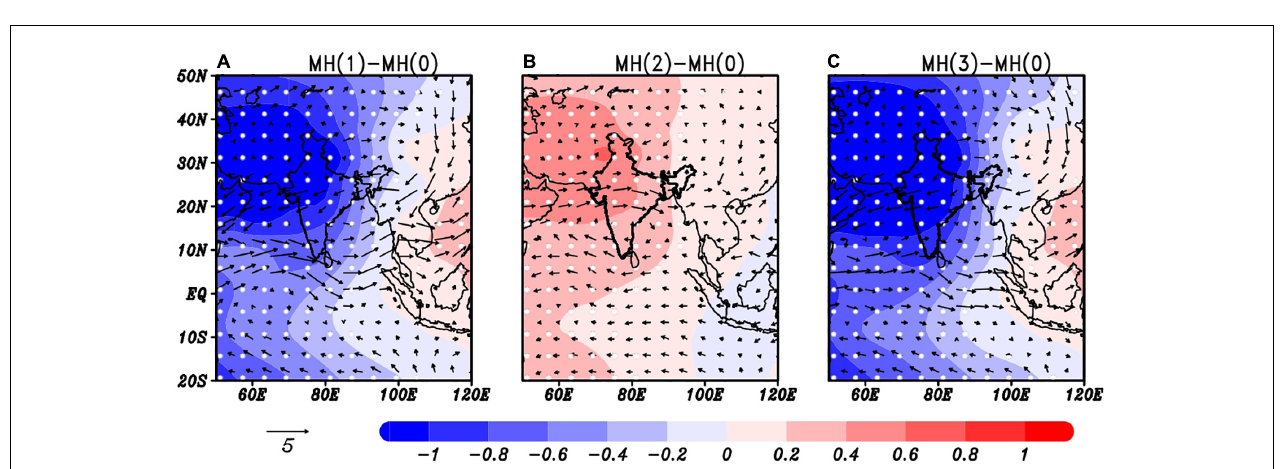
FIGURE 10 | Spatial distribution of the simulated 850 hPa differences in the time-averaged JJAS velocity potential ‘ χ 850’ (m 2 s − 1 ; Shaded), and overlaid by the mean monsoon winds (m/s; Vectors) for MH sensitivity experiments relative to that for the MH control simulation. (A) MH sensitivity experiment with HS orbital parameters to MH control simulation, (B) MH sensitivity experiment with 8.2 kyr BP orbital parameters to MH control simulation, and (C) MH sensitivity experiment with LGM orbital parameters to MH control